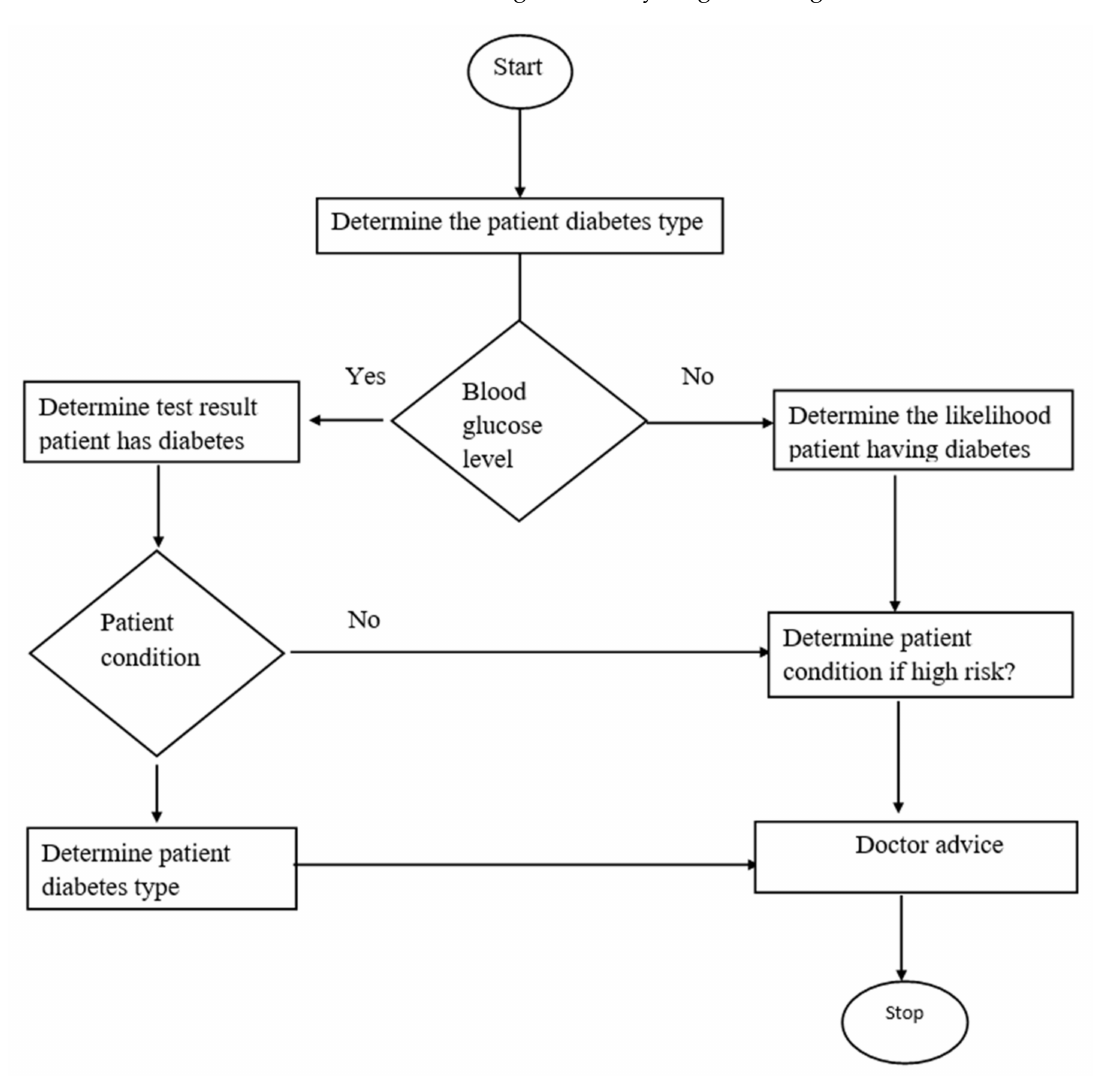
Figure 3. Flow chart diagram diabetes telehealth